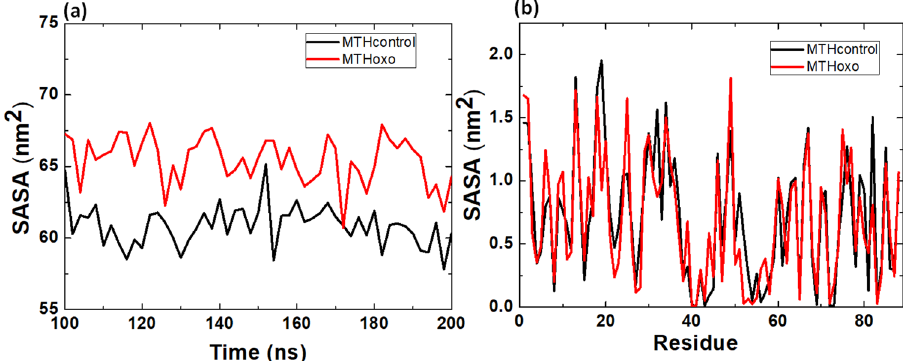
Figure 6. ( a ) SASA as function of time (ns) and ( b ) SASA per residue, for MTH control and